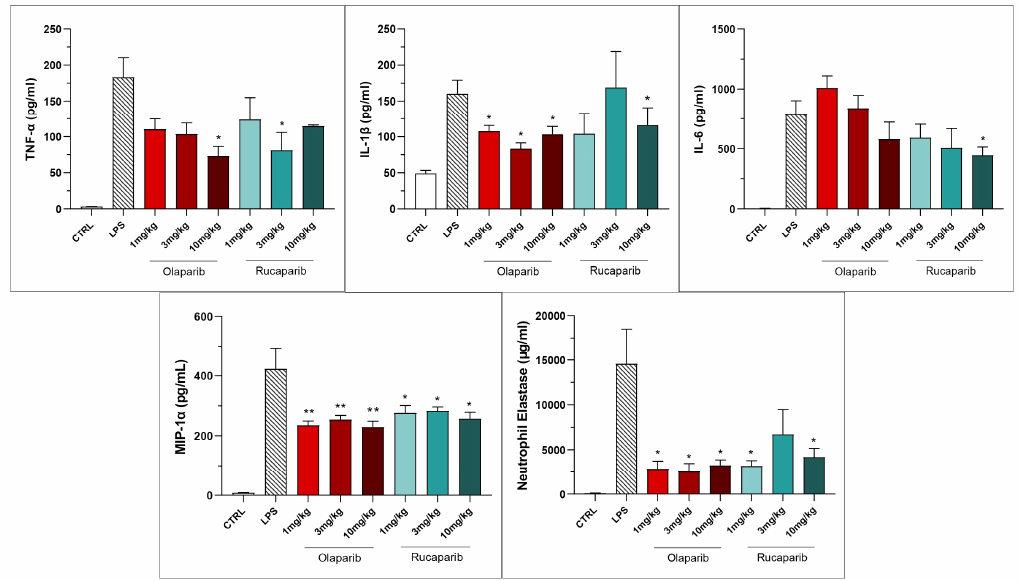
Figure 15. Bronchoalveolar lavage fluid in a murine model of ALI. C57Bl/6 mice received either PBS (30 µL) or LPS (50 µg in 30 µL PBS) by intratracheal instillation in the absence or presence of various doses (1, 3, or 10 mg/kg) of olaparib or rucaparib. After 24 h, bronchoalveolar lavage fluid was collected, and TNFα, IL-1β, IL-6, and MIP-1α or neutrophil elastase levels were measured. * p < 0.05 and ** p < 0.01 indicates inhibitory effects of the PARP inhibitors tested on various mediator levels in LPS-treated animals. Data are shown as mean ± SEM, n = 8–12/group.